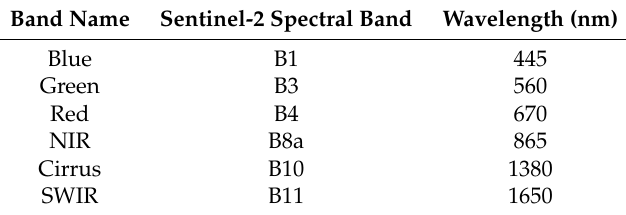
Table 2. Spectral bands used in the various cloud detection tests. NIR stands for Near Infra-Red and SWIR for Short Wave